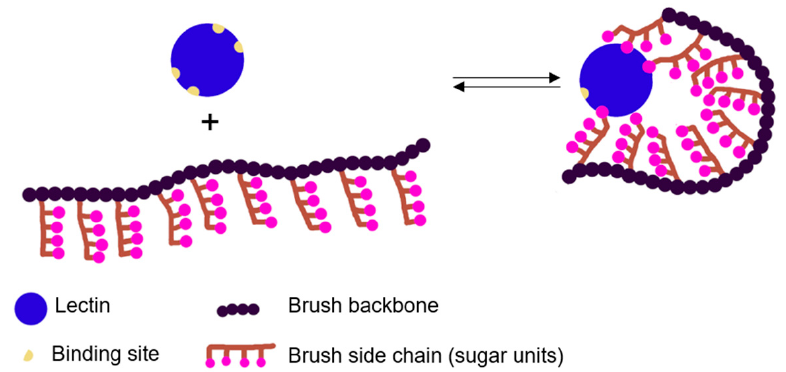
Figure 2. Schematic representation of the binding between a lectin and a glycopolymer brush chain by the multivalent effect.